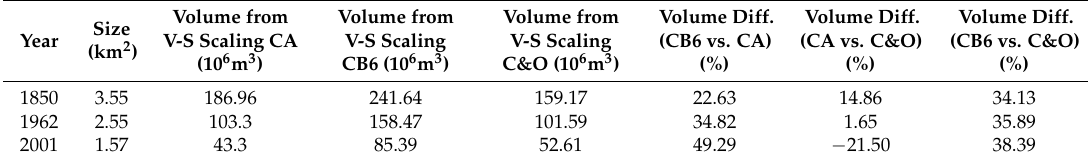
Table 4. Difference in the V-S scaling of QUE between the CA model and six glaciers in the Cordillera Blanca [19,64].